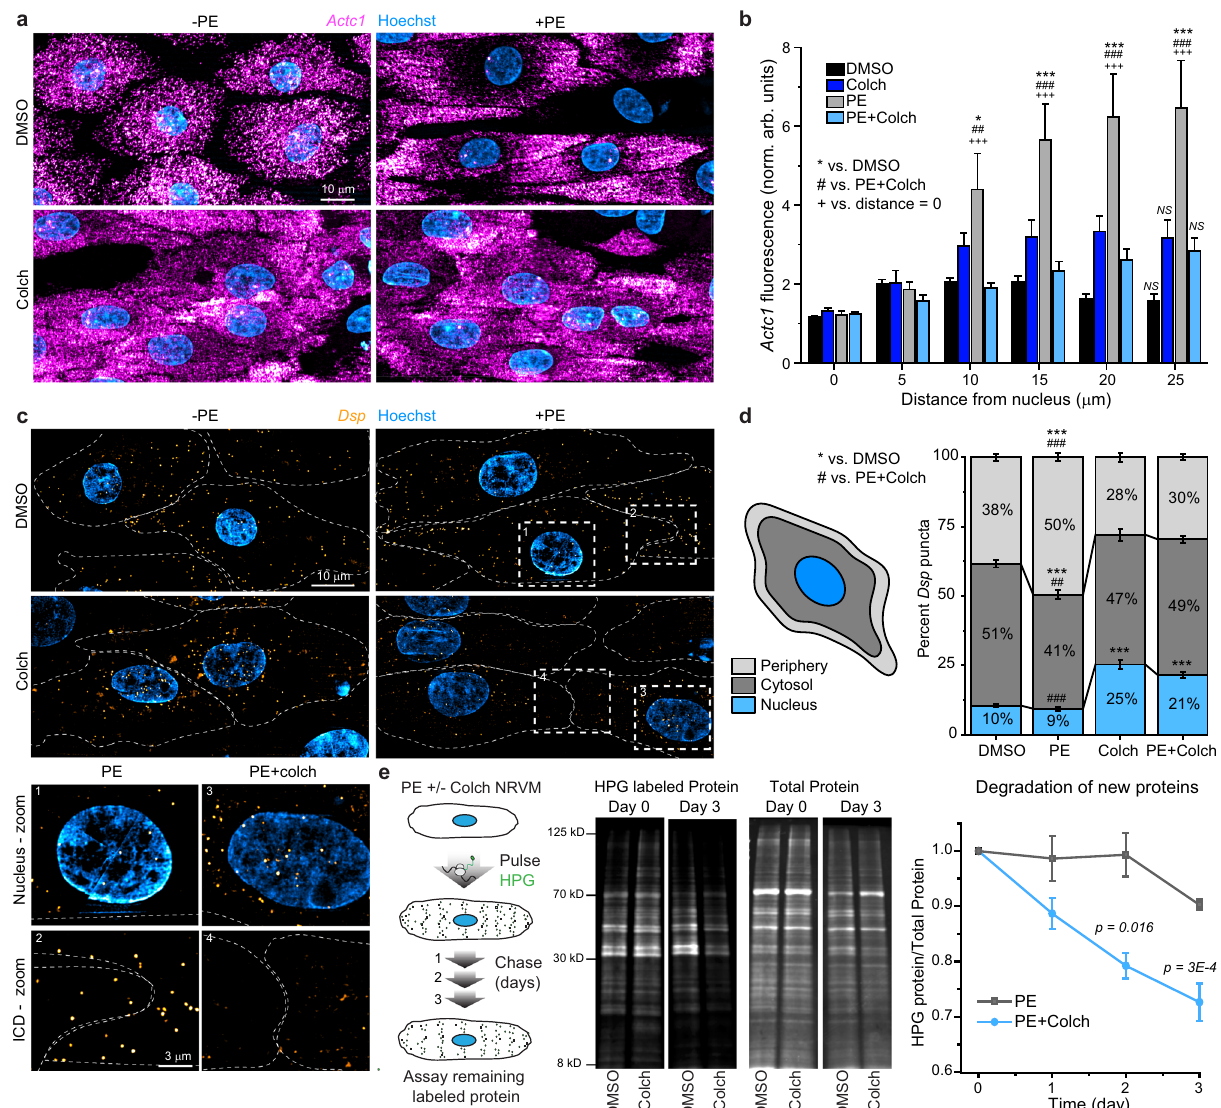
Fig. 3 Microtubule-dependent peripheralization of mRNA transcripts is concomitant with cardiac hypertrophy. a Representative images of NRVMs treated with DMSO, PE, Colch, and PE + Colch and hybridized for Actc1 mRNA. b Quantitative line scan analysis of images from a . After normalization to the initial value, mean fl uorescence intensities were binned every 5 µ m from the center of the nucleus outward for each cell. DMSO ( n = 96), PE ( n = 85), Colch ( n = 82), and PE + Colch ( n = 103). Signi fi cance of PE group from either DMSO (*), PE + Colch (#) or initial PE measurement at distance = 0 ( + ) indicated by number of symbols, i.e., # p < 0.05, ## p < 0.01, and ### p < 0.001. Corresponding data points were omitted in overlay due to high n value and high variability, causing dif fi culty in visualization. c Representative images of NRVMs treated with DMSO, PE, Colch, and PE + Colch and hybridized for Dsp mRNA. Numbered insets show zoomed-in regions. d Quanti fi cation of c . DMSO ( n = 82), PE ( n = 88), Colch ( n = 76), and PE + Colch ( n = 87). Signi fi cance of PE group from either DMSO (*), PE + Colch (#) indicated by number of symbols, i.e., ## p < 0.01 and *** or ### p < 0.001. e (left) Experimental design for measurement of protein degradation rate using pulse HPG labeling. (middle) Representative western blots of HPG-labeled protein over time. (right) Quanti fi cation of relative remaining HPG over time. For all data in fi gure, statistical signi fi cance determined via two-way ANOVA with post hoc Bonferroni comparison, and data are from four independent NRVM litters. For all graphs shown in fi gure, whiskers denote standard error (SE) from the mean. Source data are provided as a Source data fi